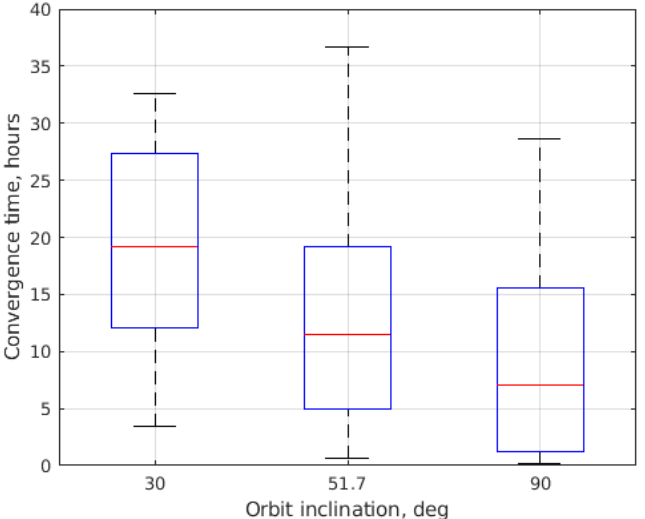
Figure 19. Convergence time depending on orbit inclination.